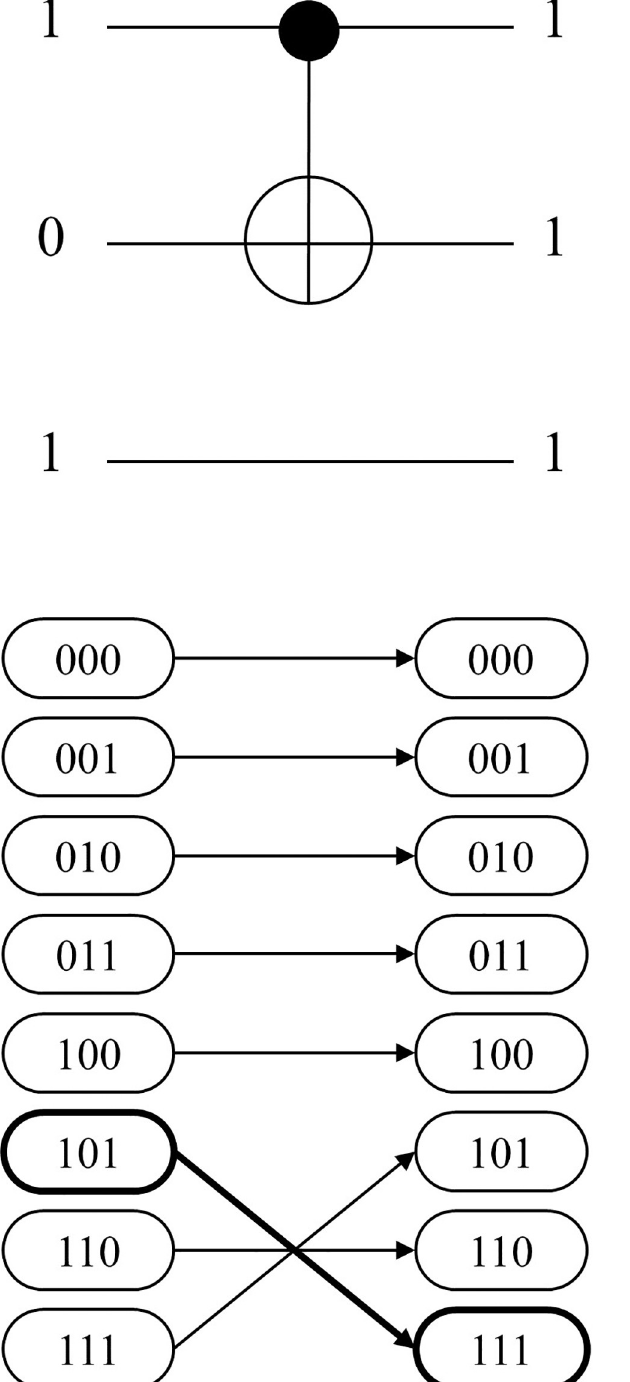
Fig 6. 3-qubit example of MCT gate-network conversion: CASE3A .